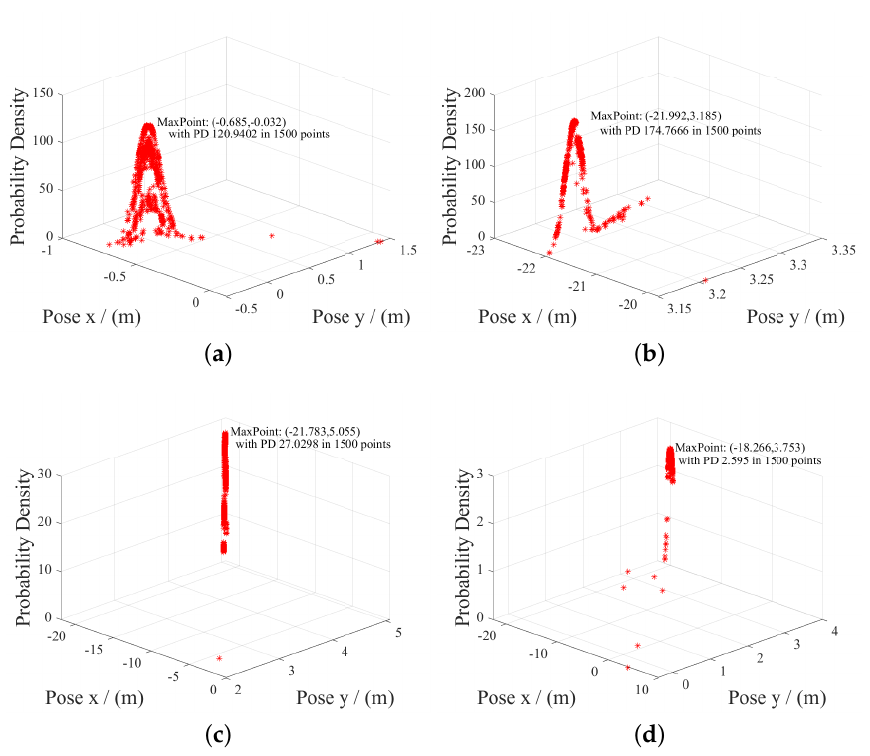
Figure 9. The probability distributions of poses is shown when UAPF conducts global localization in four positions, ( a ) ( x true , y true ) = ( − 0.6,0), ( x true , y true ) = ( b ) ( − 22,3), ( x true , y true ) = ( c ) ( − 21.7,5), ( d ) ( x true , y true ) = ( − 18,3.7), which obey Gaussian distributions and is consistent with some theoretical hypotheses.